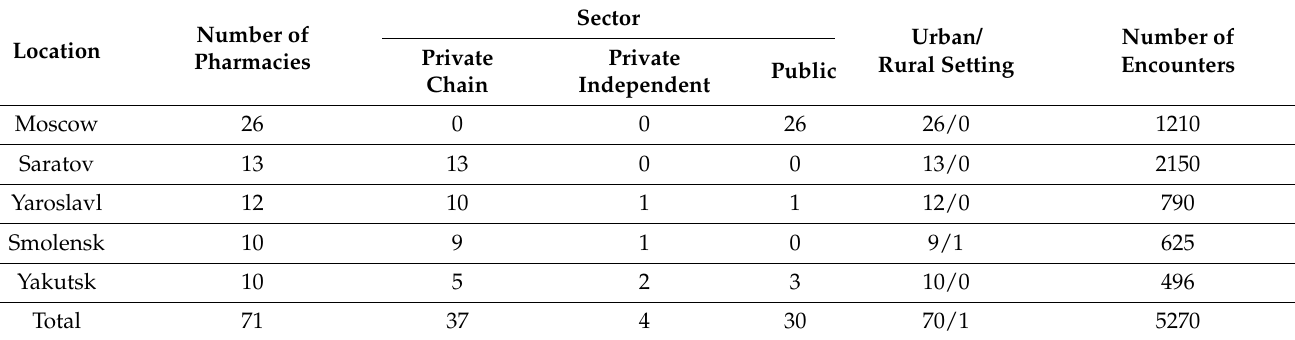
Table 1. Main characteristics of community